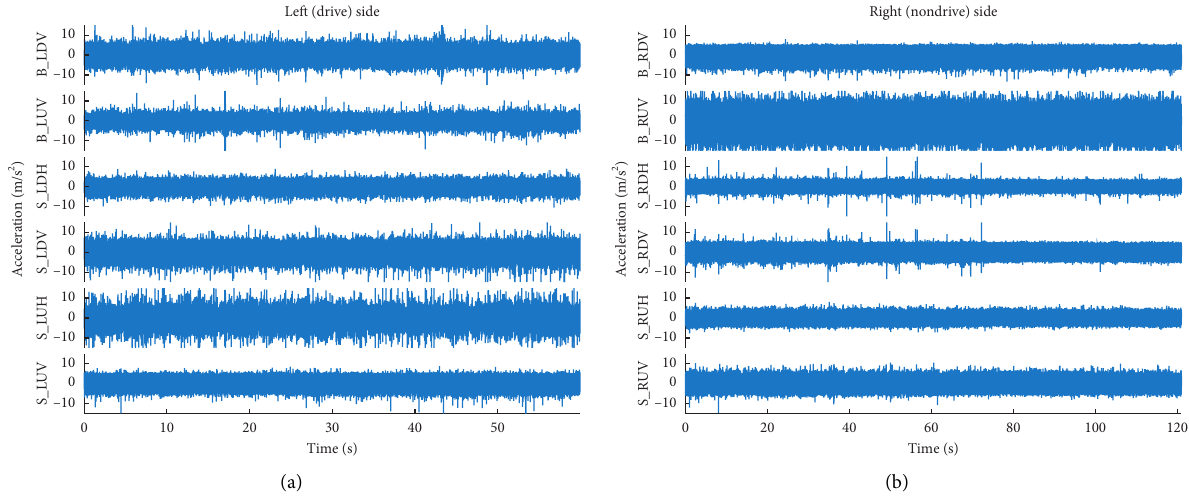
Figure 11: Signals of screen acceleration measured on the left (drive) side (a) and right (nondrive) side (b).